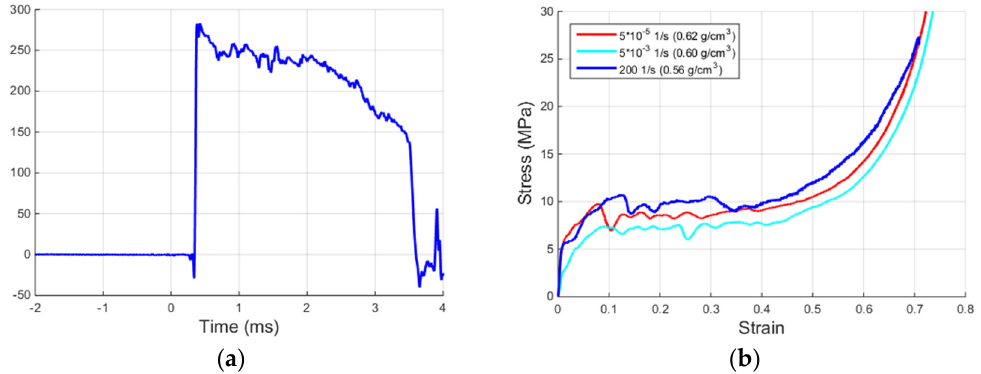
Figure 10. ( a ) Specimen strain-rate during a MHPB-SM test; and ( b ) engineering stress-strain curve of ALUHAB foam.